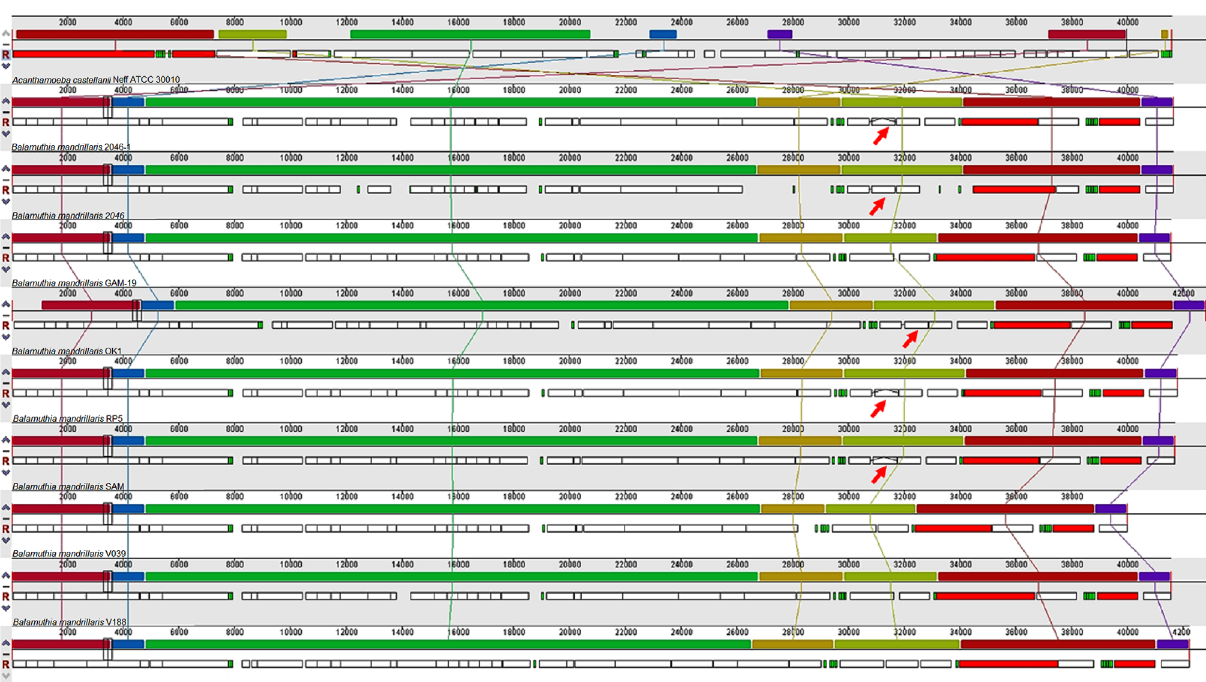
Figure 2. Alignment of B. mandrillaris mitochondrial genomes (mtDNA), using A. castellanii mtDNA as a reference. The lines show the synteny between the genomes. The upper rectangles show the locally collinear blocks and the lower boxes the annotated genes: red (rRNA), green (tRNA), and white CDS (coding sequence). Red arrows indicate the presence of the LAGLIDADG sequence disrupting the cox1